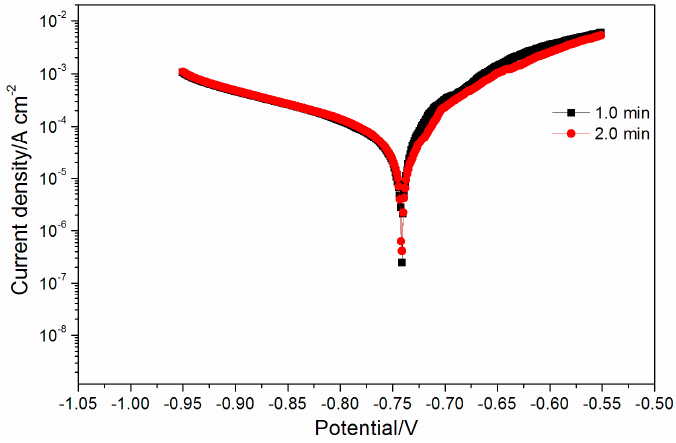
Figure 9. The electrochemical curve of the coating at drying time of 1.0 and 2.0 min. Table 7. E ff ect of drying time on corrosion resistance of the